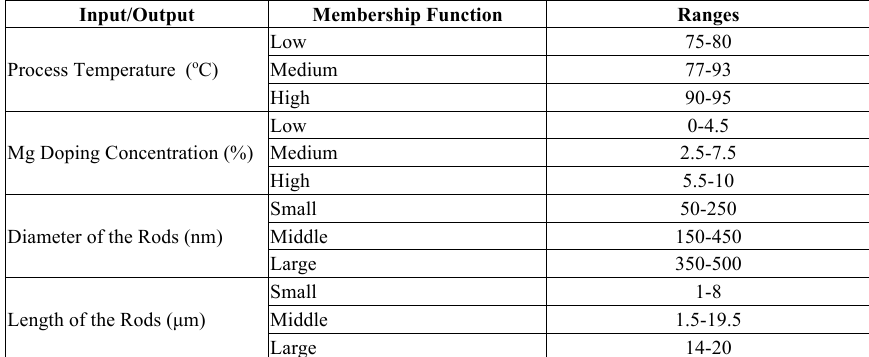
Table 1. Ranges of Every Membership Function of Input and